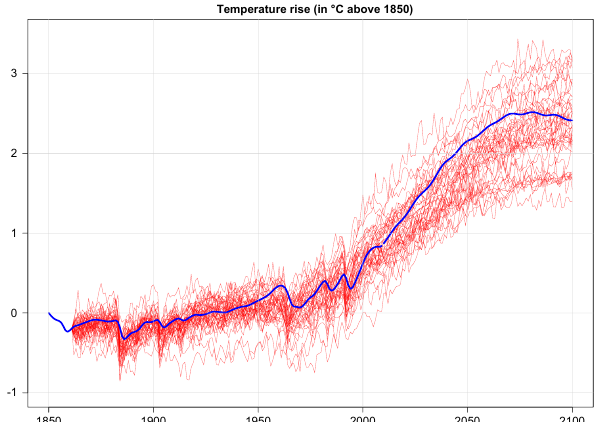
Figure 7. Temperature rise from 1850 in ESCIMO when driven by the RCP4.5 emissions scenario (blue) compared to the output from 42 models (the CIMP5 ensemble) driven by the same emissions sce- nario (red). World 1850 to